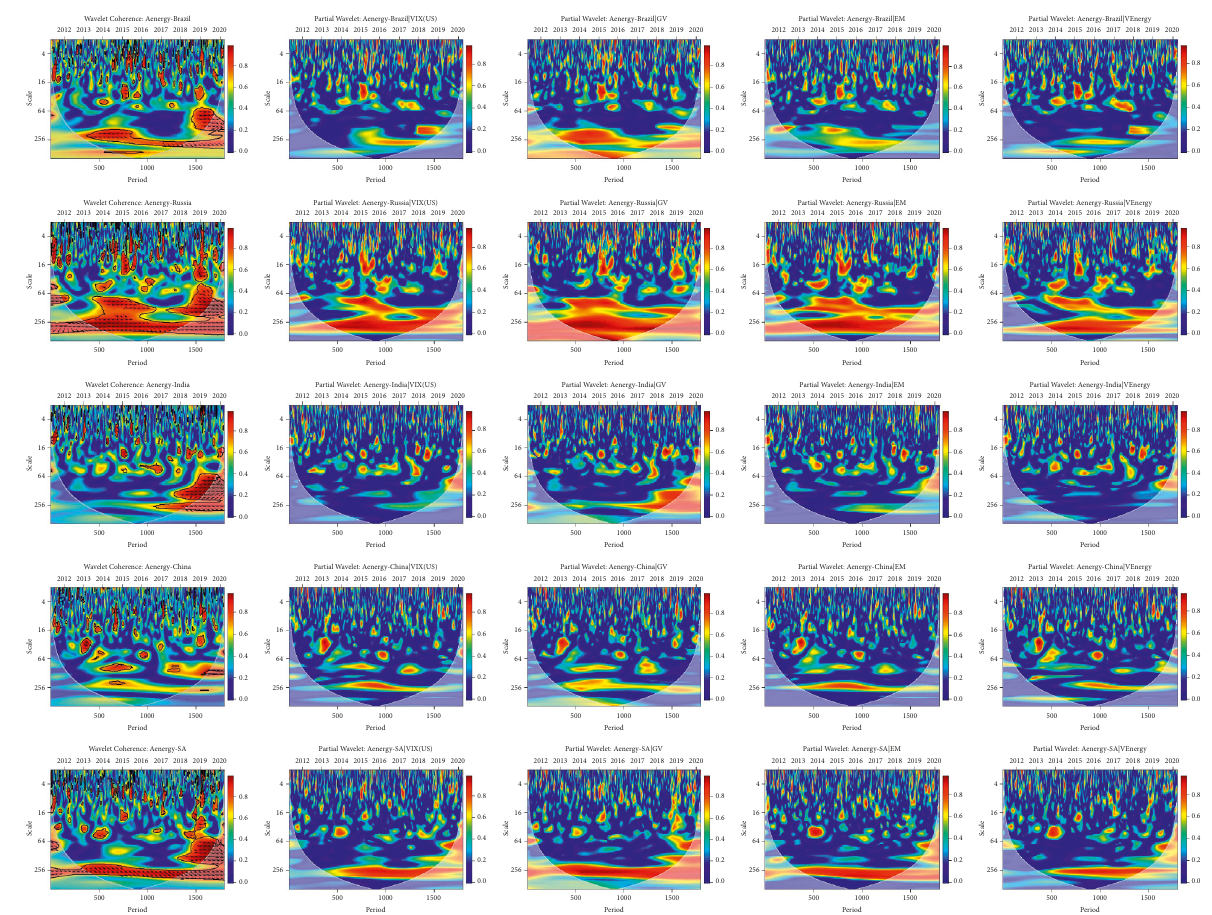
Figure 2: Comovements among global energy, BRICS, and volatility